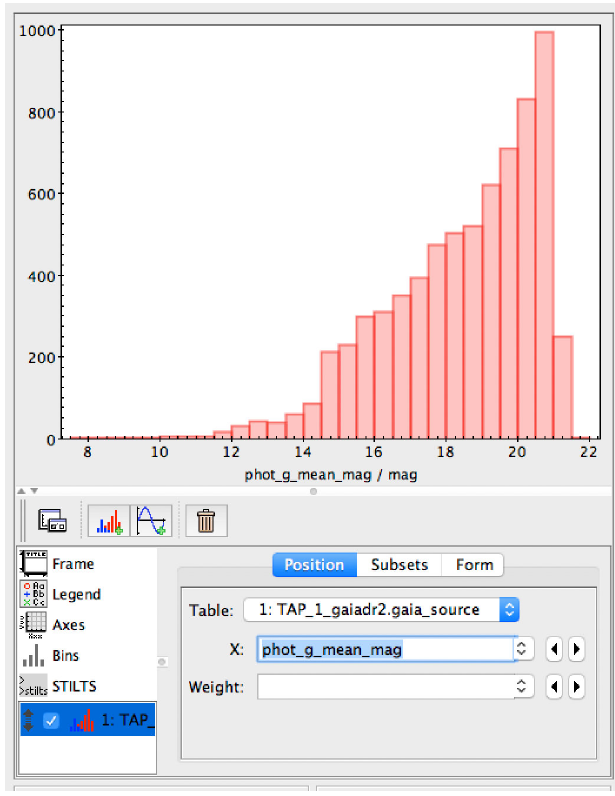
Fig. 75.— Histogram for the g brightness in the stars in the region of NGC 188 and measurement bias. In general, less luminous stars